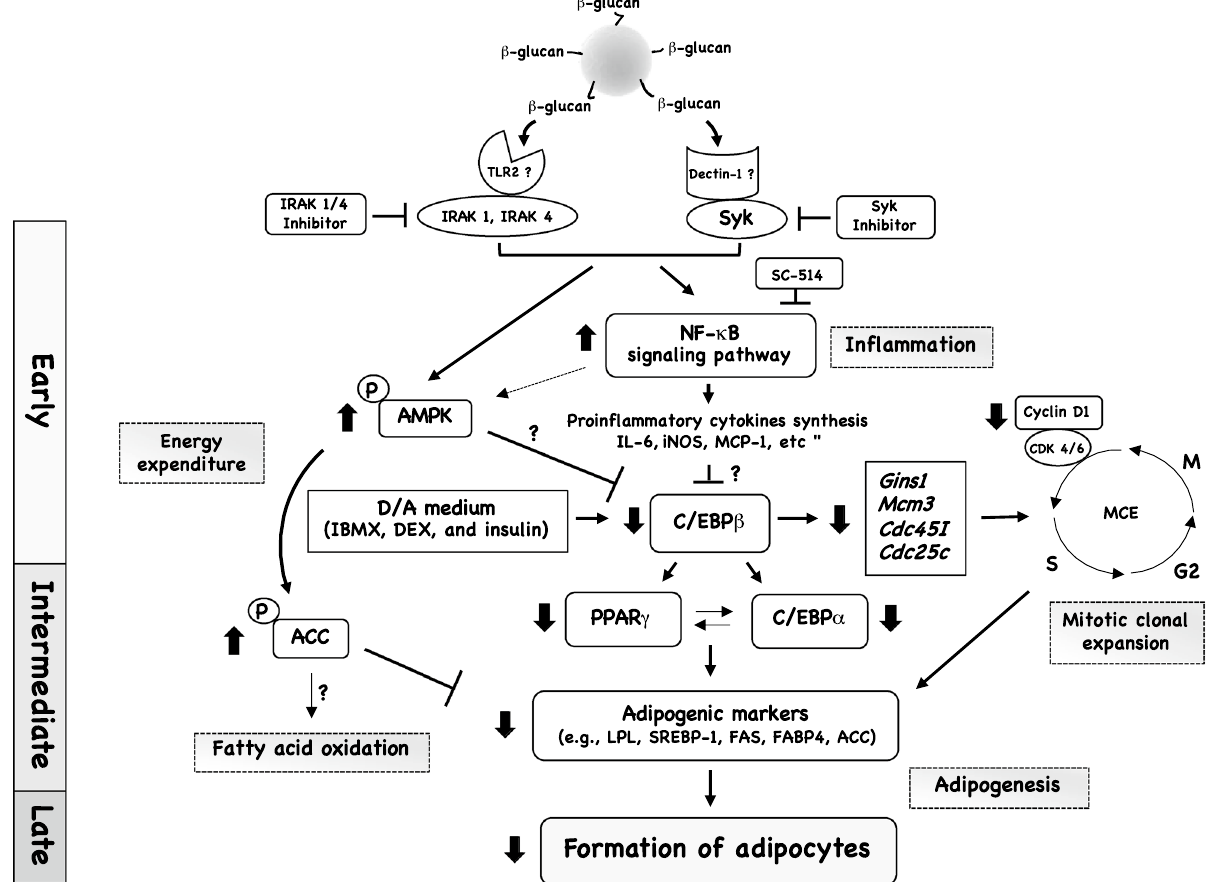
Figure 8. A proposed mechanism of how LCB inhibits lipid accumulation in 3T3-L1 adipocytes. In order for LCB to inhibit adipogenesis in 3T3-L1 adipocytes, LCB must be introduced during the early stage of adipogenic differentiation. In this model, β-glucans on LCB may be recognized by both TLR2 and Dectin-1 receptors on the surface of 3T3-L1 adipocytes. CLEC7A/Dectin-1 transmits its signal through the SYK protein, which can be inhibited by the SYK inhibitor, whereas TLR2 signaling is dependent on IRAK1 or IRAK4 protein, which is blocked by the IRAK 1/4 inhibitor. These two receptors synergistically stimulate the two major pathways: AMPK and the NF-κB signaling pathways. AMPK may inhibit C/EBPβ protein. ACC protein, which is phosphorylated by the AMPK complex, inhibits the expression of key adipogenic markers such as LPL, SREBP-1, FAS,